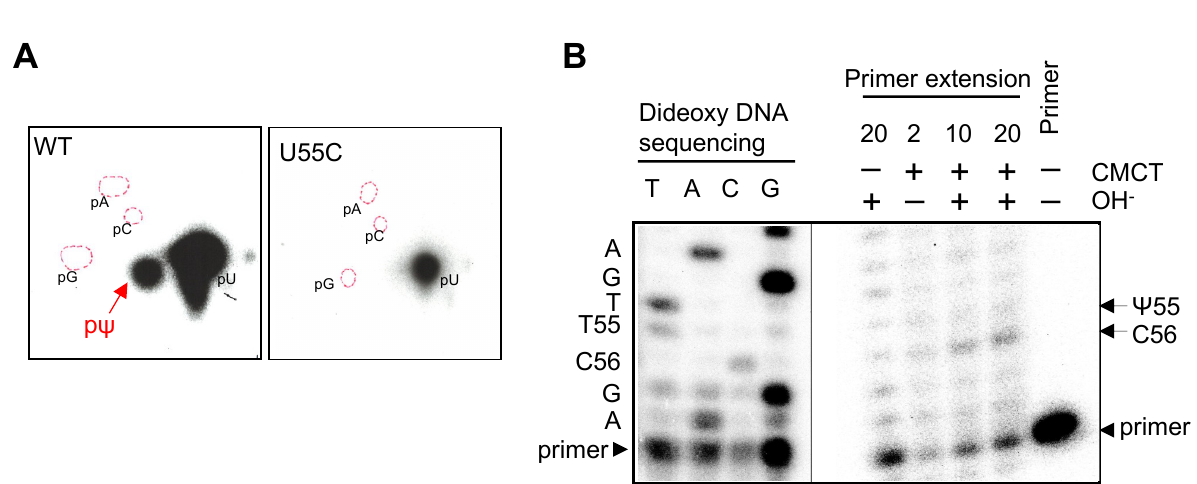
Figure 3. Pseudouridylation activities of cmPus4 towards intronless tRNA Ile (UAU) in vitro. ( A ) The α - 32 P-UTP-labeled tRNA Ile (UAU) transcript of the wild type or the U55C mutant was incubated with cmPus4, and the Ψ formation was analyzed by 2D-TLC. A p Ψ spot was detected only in the wild type tRNA Ile (UAU) transcript. ( B ) The position of Ψ in intronless tRNA Ile (UAU) treated with cmPus4 was detected by CMCT-RT using the primer II as shown in Figure 2A. The transcripts were treated with CMCT for 10 or 20 min plus or minus alkaline (OH − ) treatment (+ or − ). Ψ modification was detected at position